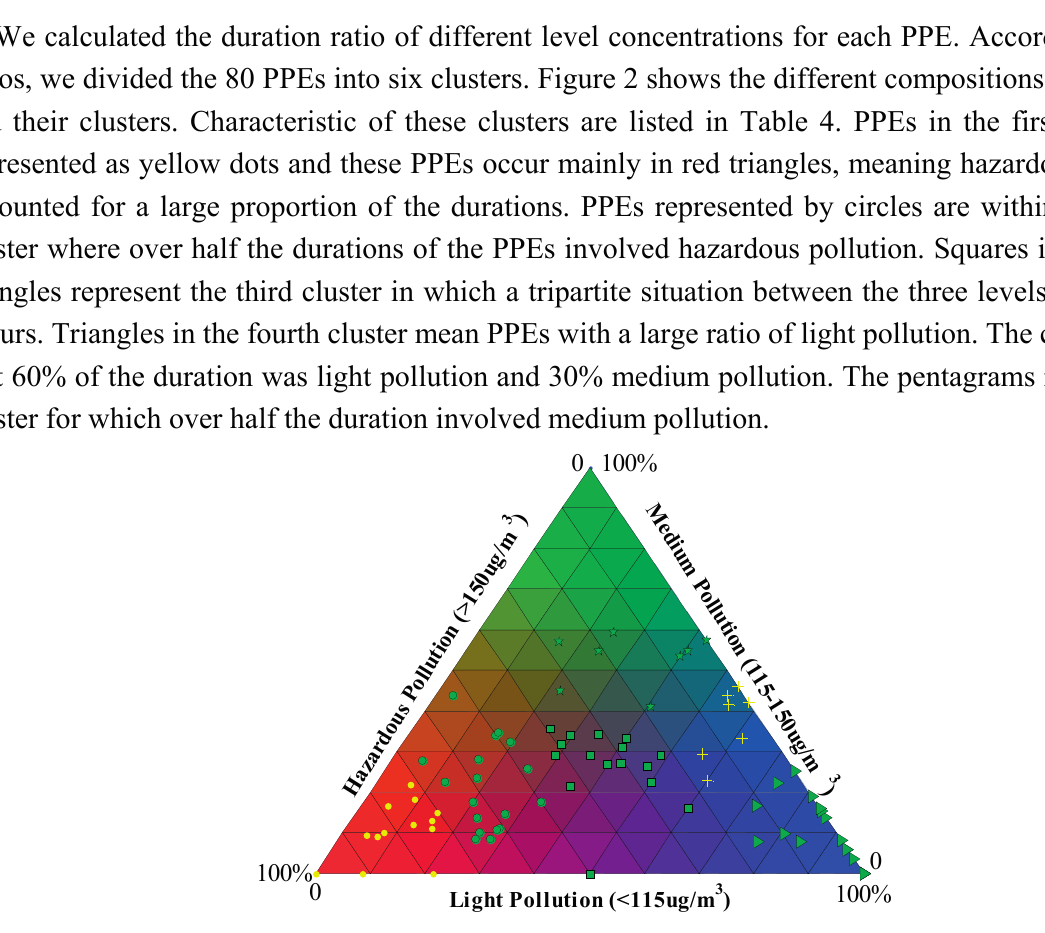
Figure 2 . PPE clusters with different compositions of pollution